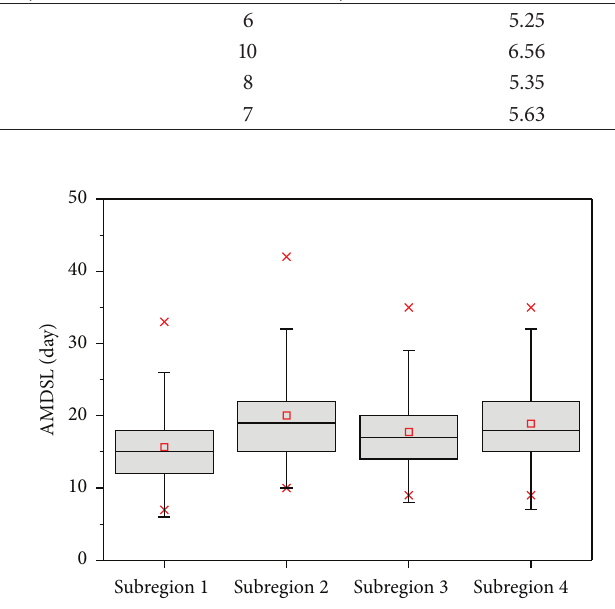
Figure 7: Boxplots of AMSDL series in each subregion of the